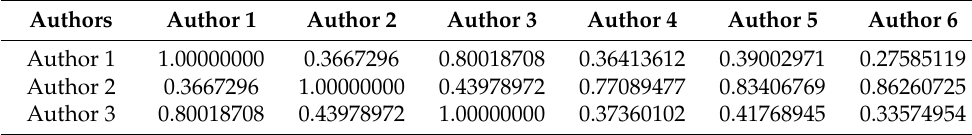
Table 10. Similarity matrix between authors based on three factors.